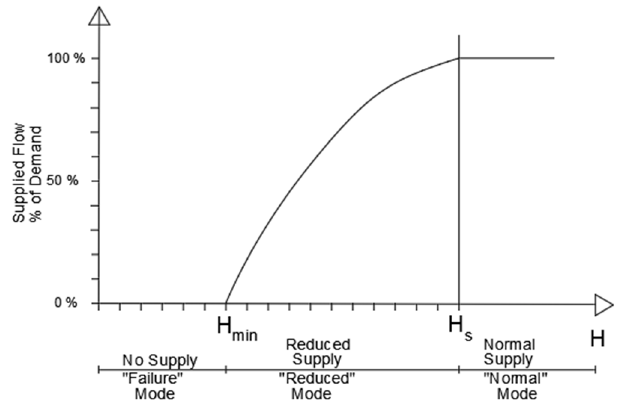
Figure 2. Relation between supplied flow and head at each node [21] .